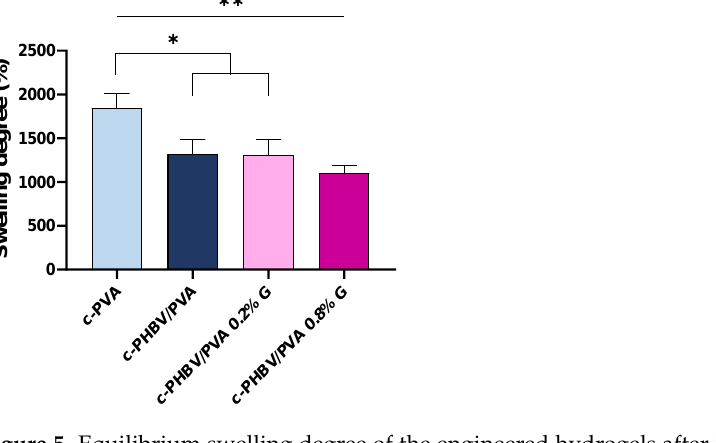
Figure 5. Equilibrium swelling degree of the engineered hydrogels after 24 h immersed in MilliQ water. Graph shows mean ± standard deviation. (*) and (**) indicate significant differences ( p < 0.05 and p < 0.01, respectively). Crosslinked PVA (c-PVA) is included as reference.